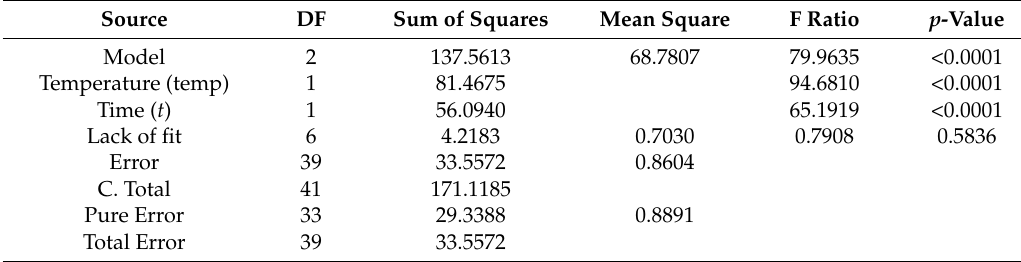
Table 6. ANOVA for effect of time ( t ) and temperature (temp) for in vitro protein digestibility for conventional